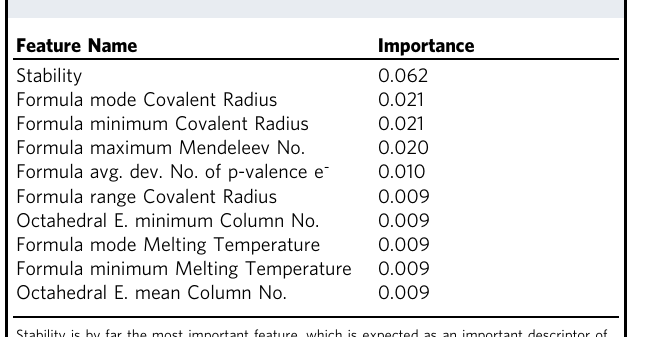
Fig. 6 Synthesizability predictions vs DFT stability for this work ’ s ML model. Energies above the convex hull for predictions made by our model on training data compounds using leave-one-out cross-validation. Data points are colored according to their true experimental labels, as either half- Heusler, another structure, or phase-separating. We observe an inverse trend between synthesizability and E max , which agrees with the intuition hull that compounds that are more stable are more likely to be